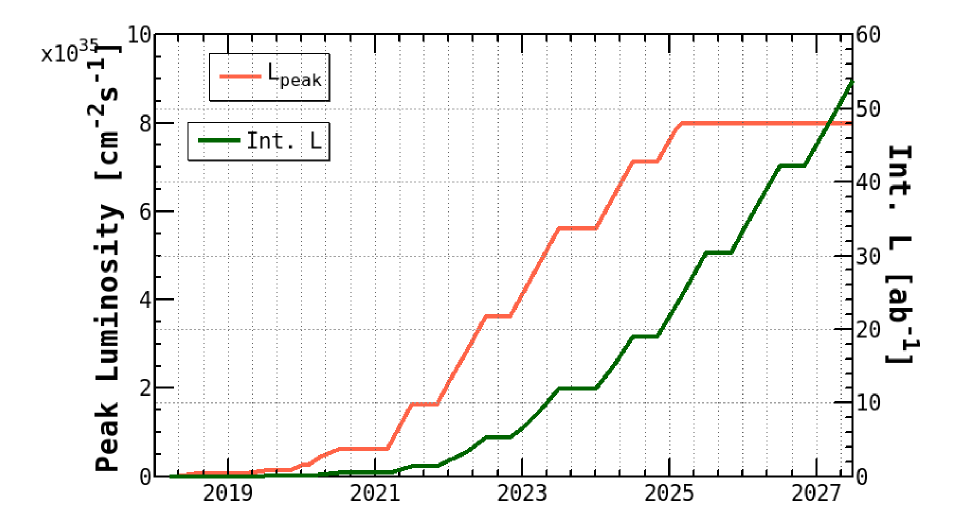
Figure 1: Projected peak and integrated luminosity for the Belle II experiment until the end of its run time. 50 ab − 1 of integrated luminosity is planned by 2027